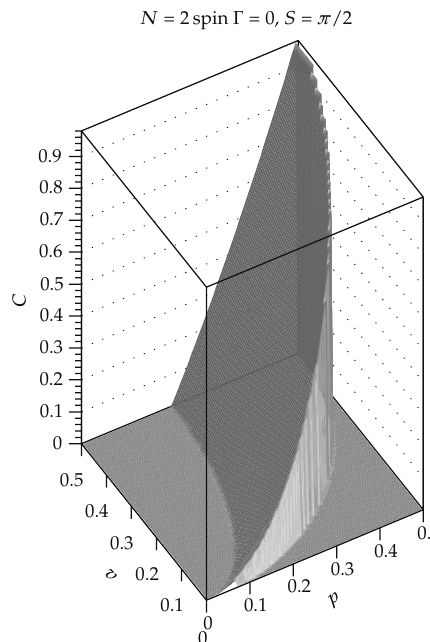
Figure 1: Maximal concurrence as a function of p and v , for fixed Γ(cid:2) t (cid:3) (cid:8) 0 ans S (cid:2) t (cid:3) (cid:8) π/ 2. Here, N (cid:8) 2 spins is